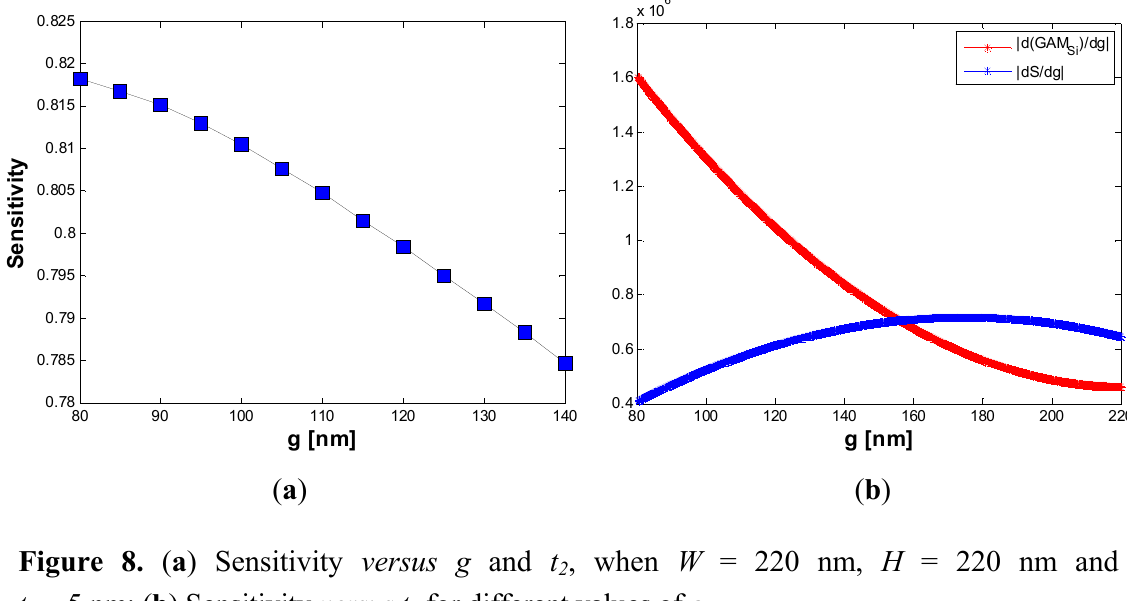
/d g versus g . Si